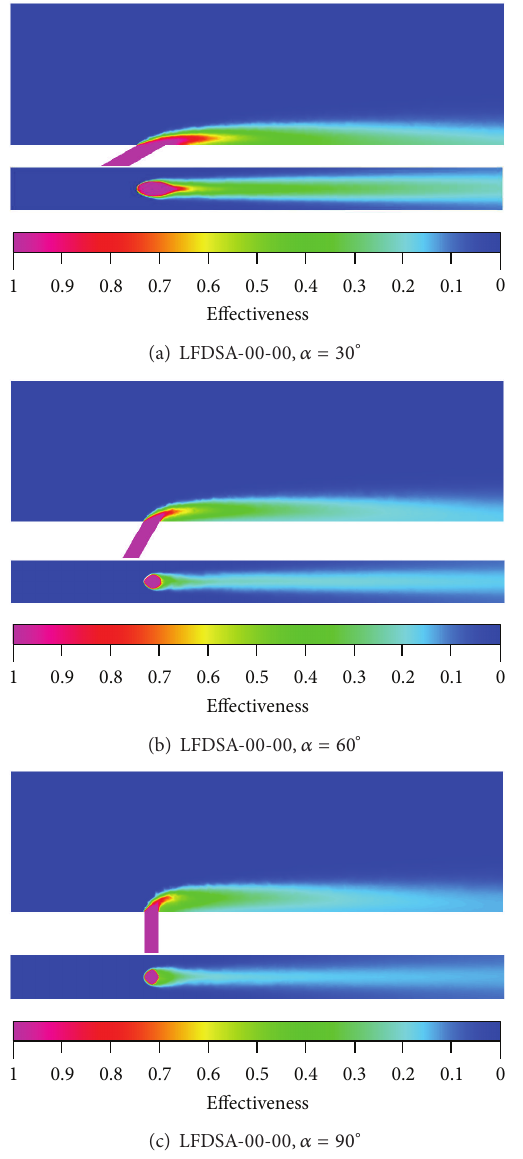
Figure 26: Top and symmetricplanes effectiveness of LFDSA-00-00 for different streamwise angles and 𝑀 = 1 .